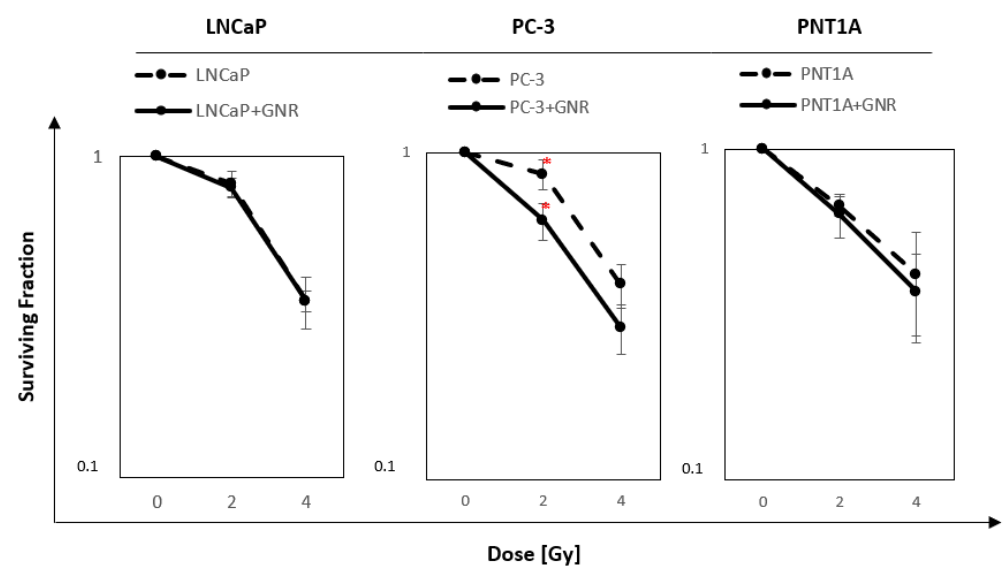
Figure 6. Survival curves after irradiation with 2 and 4 Gy doses of cells previously incubated with 6 µ M GNR for a time determined by the highest value of nanorods absorption by selected cell lines. Survival curves for LNCaP after 6 h of incubation time, for PC-3 after 4 h of incubation time, and for PNT1A after 4 h of incubation time. Values with red “*” mean the only statistically significant difference ( p < 0.05) between values in the point of 2 Gy. The values presented in the graph are the mean of the obtained results, and the deviation is the standard deviation. The experiment was performed in triplicate.